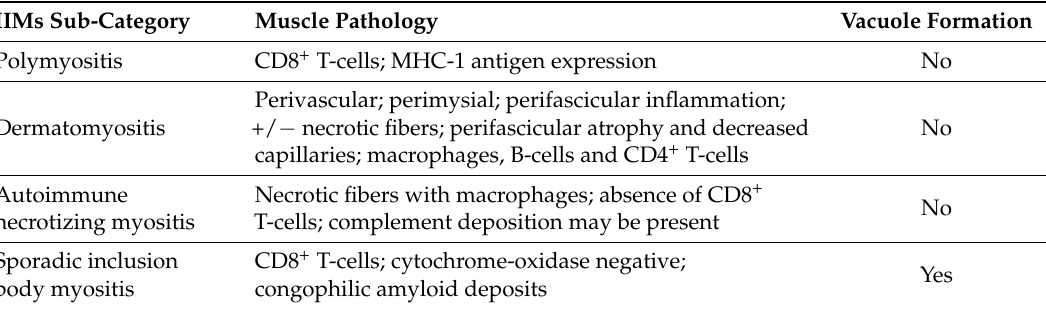
Table 1. Idiopathic inflammatory myopathies subcategories and classical muscle biopsy pathology findings [1,4]. The presence of vacuoles are pathognomonic for inclusion body myositis [1,4]. Idiopathic inflammatory myositis (IIM); Major histocompatibility complex